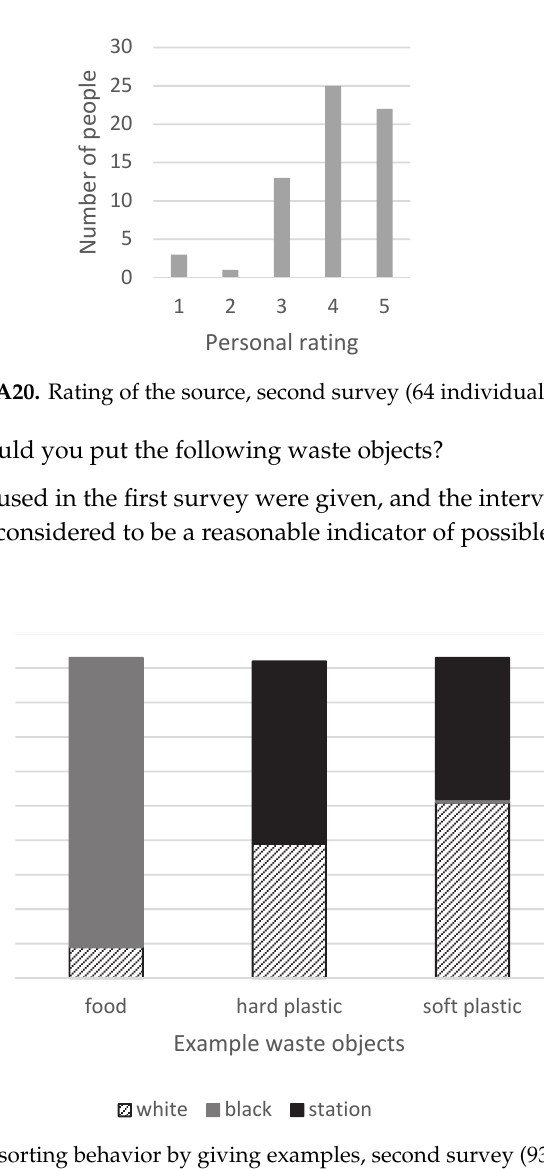
Figure A20. Rating of the source, second survey (64 individuals).